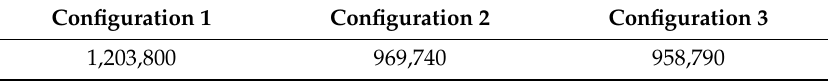
Figure 9. Total costs of scheduled reserves under different DR marginal costs.